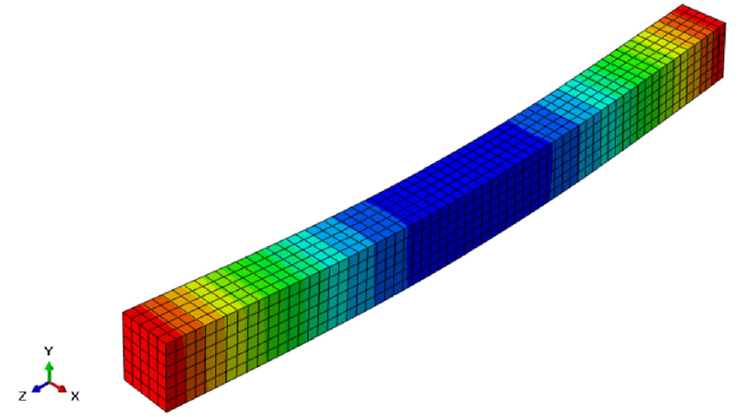
Figure 8. Typical deflected shape of ECC beam (units: mm).